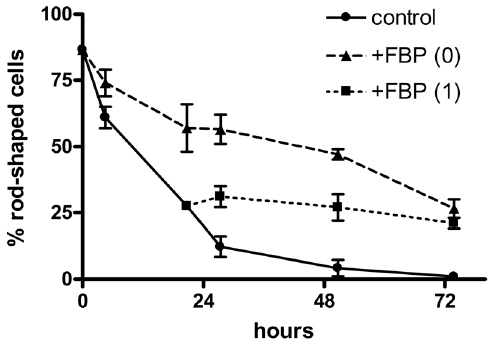
Figure 1. Effects of FBP addition after one day of hypothermic incubation. Cardiac myocytes were incubated at 3 u C for the time indicated on the x-axis, with additions of 5 mM fructose-1,6-bispho- sphate prior to the beginning of the incubation (triangles) or after one day (squares); controls (circles) had no addition. The percentage of rod- shaped cells at each time point is shown. Results are means from two experiments. Error bars indicate the individual values (in some cases the bars lie within the symbols).